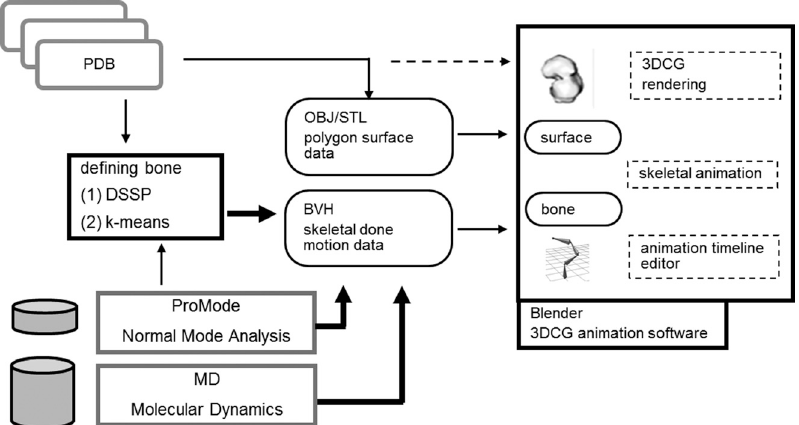
Figure 2: Work flow for the proposed skeletal animation using blender. Molecular objects are built from the atomic coordinate modelPDBontothe polygonsurfaceintheOBJor STLformat.They areanimatedinblenderusingskeletalanimationaccordingto thedefinedbones.Thetwomethodsusedfordefiningbonesaredescribedinthetext:(1)DSSPand(2)k-means.Resultsofnormal modeanalysisandmoleculardynamicscalculationareconvertedtothemotiondatasavedinBVHfileformattofacilitatehandling with existing 3D CG animation